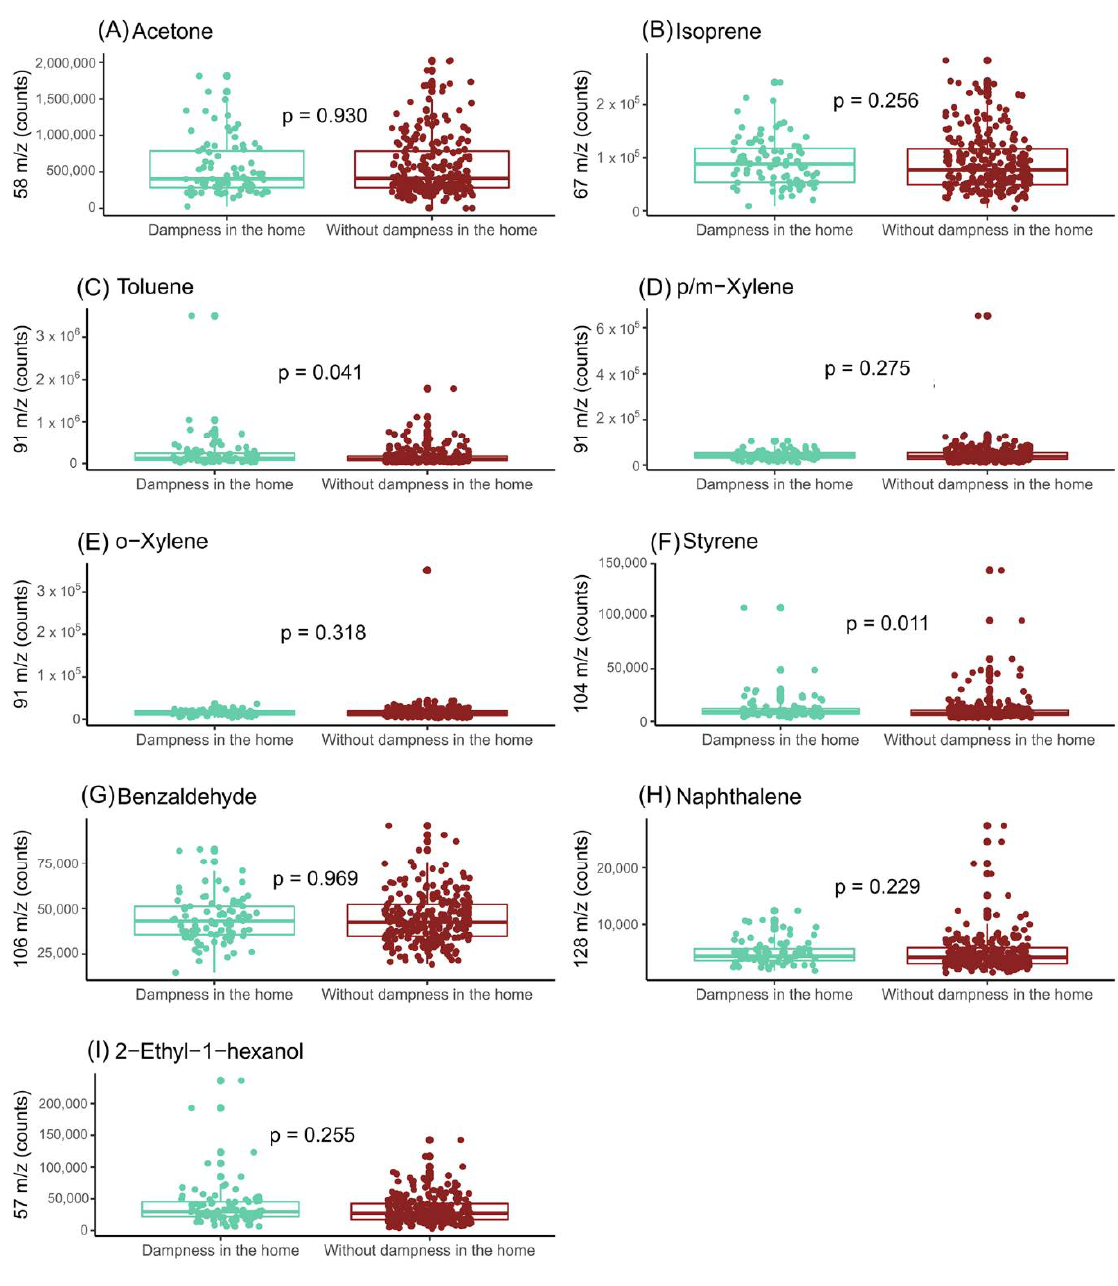
Figure 3. Assessment of influence of indoor-dampness exposure on the levels of the features selected in ambient air from room collection. ( A ) Impact of indoor-dampness exposure on levels of acetone ( m/z = 58); ( B ) impact of indoor-dampness exposure on levels of isoprene ( m/z = 67); ( C ) impact of indoor-dampness exposure on levels of toluene ( m/z = 91); ( D ) impact of indoor-dampness exposure on levels of p/m-xylene ( m/z = 91); ( E ) impact of indoor-dampness exposure on levels of o-xylene ( m/z = 91); ( F ) impact of indoor-dampness exposure on levels of styrene ( m/z = 104); ( G ) impact of indoor-dampness exposure on levels of benzaldehyde ( m/z = 106); ( H ) impact of indoor-dampness exposure on levels of naphthalene ( m/z = 128); and ( I ) Impact of indoor-dampness exposure on levels of 2-ethyl-1-hexanol ( m/z = 57) in room air-content samples.